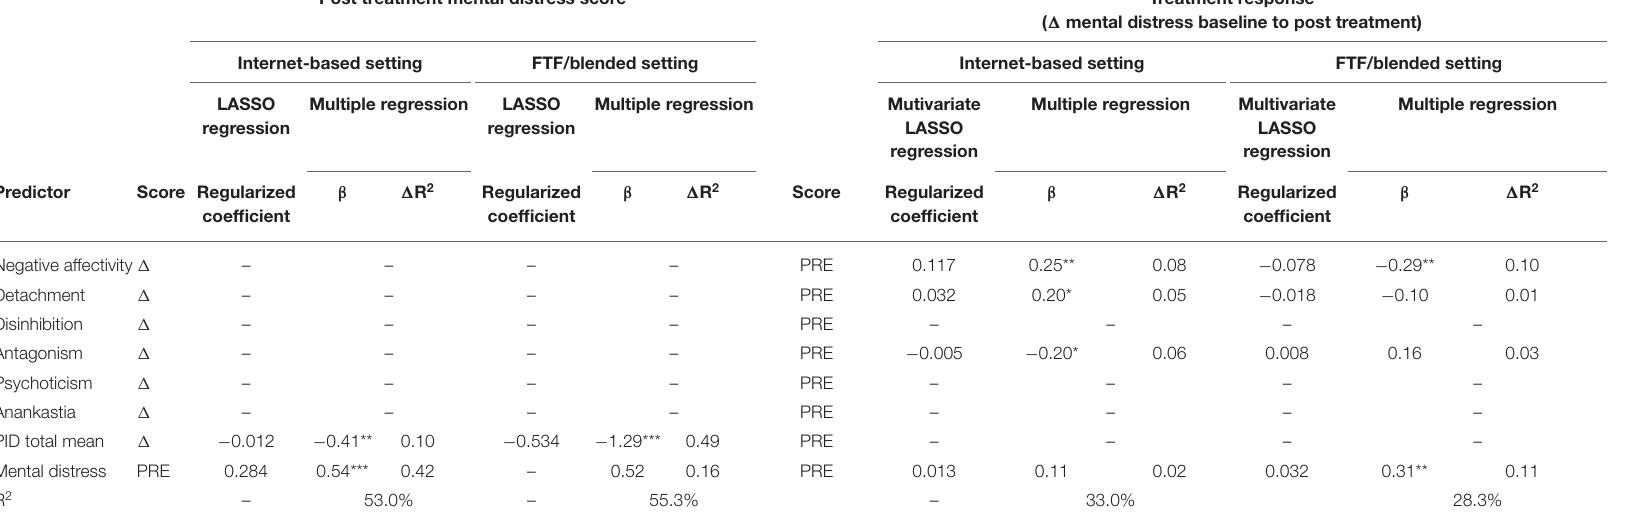
TABLE 1 | Results of LASSO regularization and multiple regression